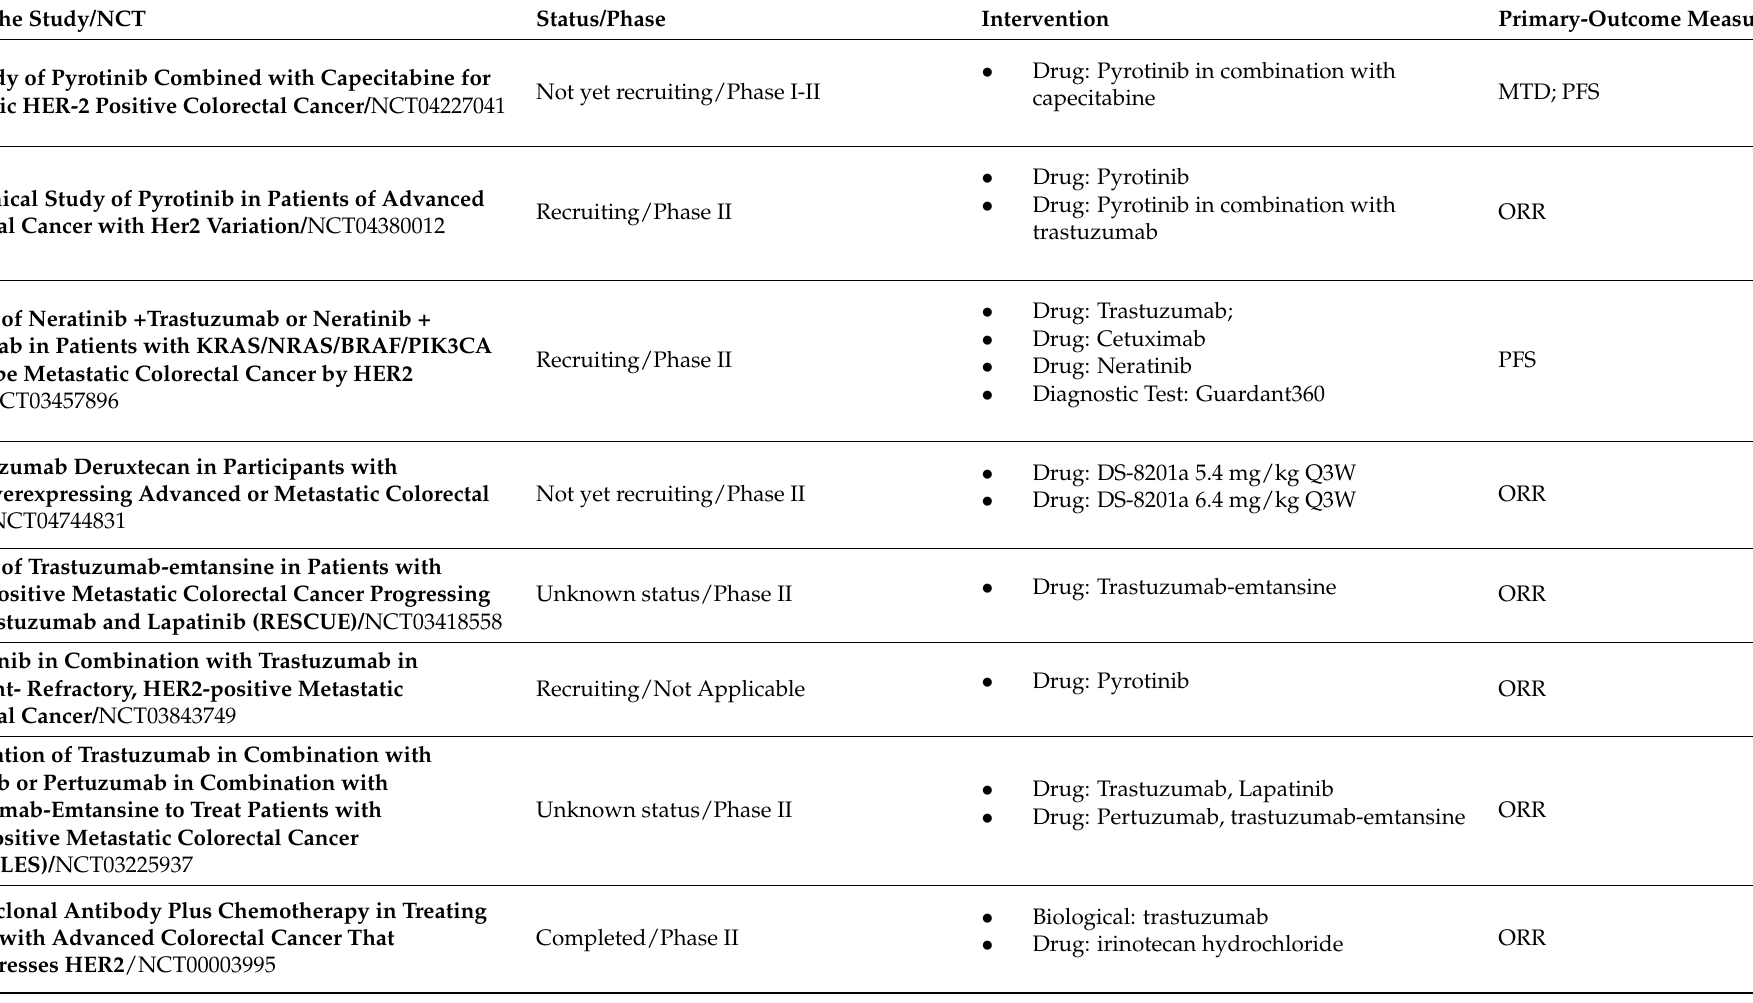
Table 2. Ongoing currently trials in HER2-positive aCRC patients (clinicalTrials.gov Search Results 05/27/2021; key words: colorectal cancer,